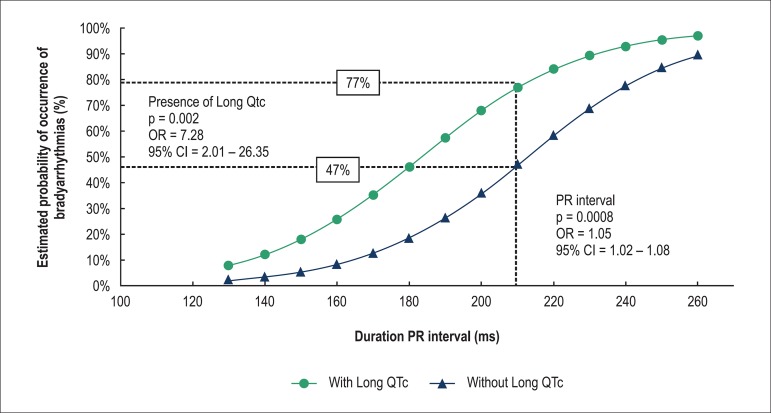
Probability of bradyarrhythmia occurrence detected by implantable loop recorder
in relation to PR interval duration stratified according to the type of QTc
manifestation (with or without long QTc).